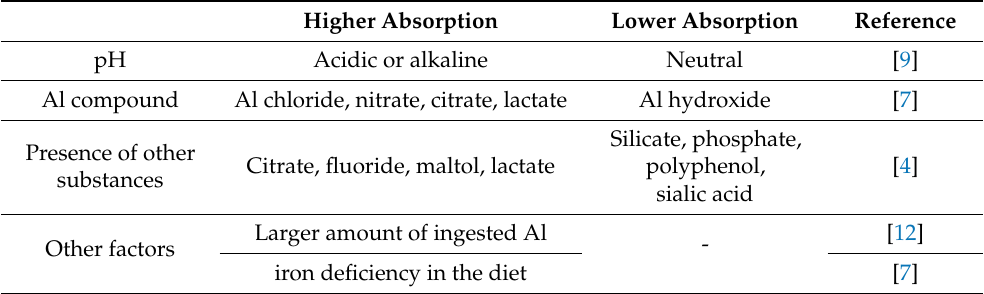
Table 3. Factors affecting gastrointestinal absorption of